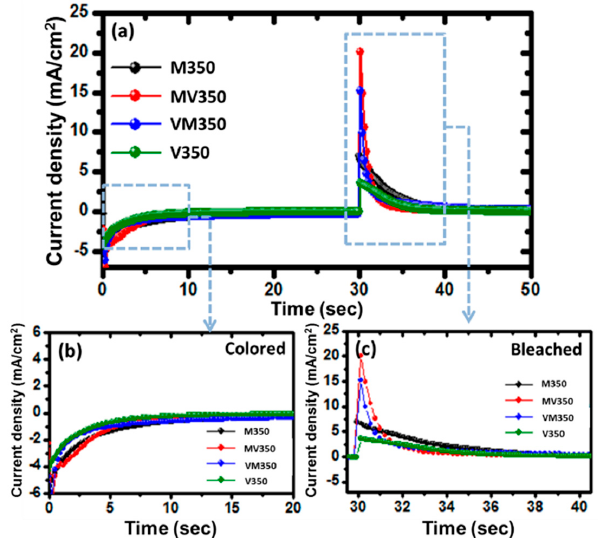
Figure 7. ( a ) Current density response of MoO 3 / V 2 O 5 hybrid nanobilayers heated at 350 ◦ C for 2 h in air. ( b ) Current density response in the colored state and ( c ) current density response in the bleached state of MoO 3 / V 2 O 5 hybrid